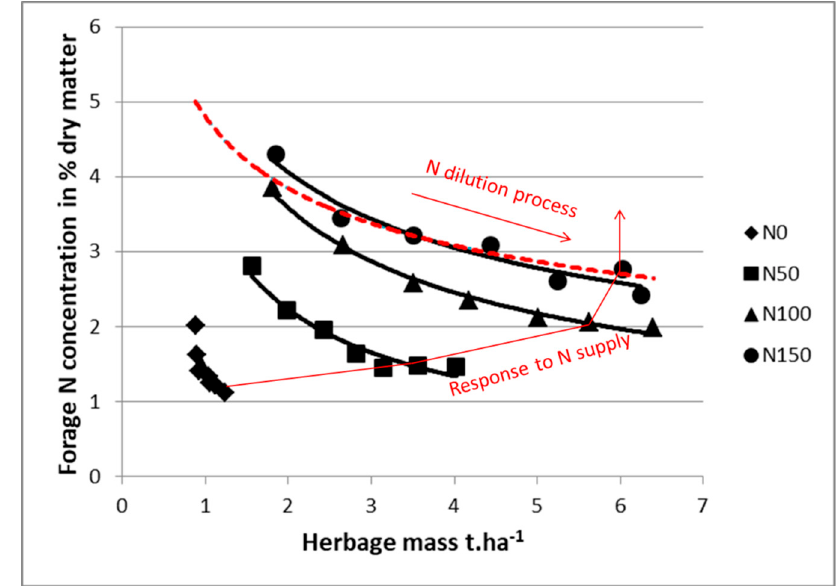
Figure 1. Variation of forage N concentration (%N) in relation to forage mass (W) during a spring growth of tall fescue under different levels of N fertilizer applications. The dotted line in red represents the critical N dilution curve: %N = 4.8W − 0.32 [12], corresponding to the minimum plant %N for achieving maximum forage mass. Above this critical curve, plant %N can increase as luxurious N accumulation, and below this curve, both %N and W decrease with the decreasing N supply. Data obtained at Lusignan (46.46° N; 0.07° E; France) and graph adapted from Lemaire and Denoix [19].